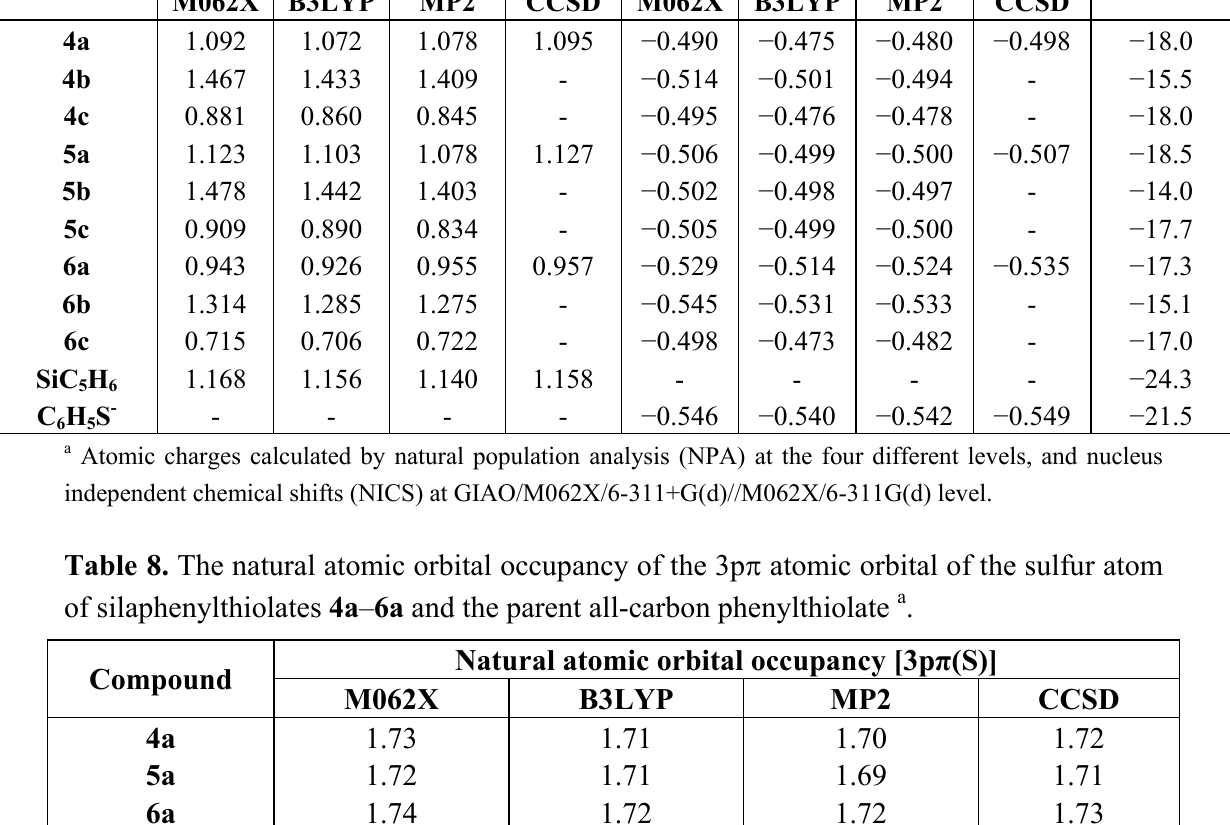
Table 7. Calculated Si and S atomic charges (e) and NICS values (ppm) of silaphenolates 4a – 6c a . Compound